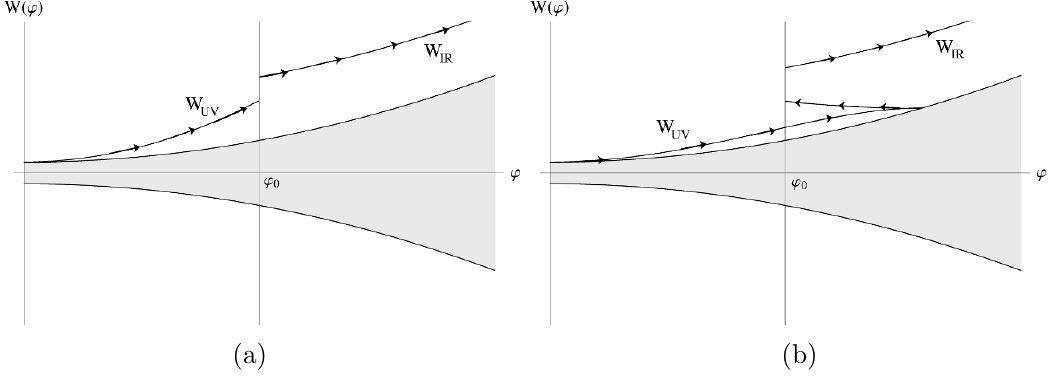
Figure 17 . The behavior of the full solution in case A 2, i.e. W B ( ’ 0 ) > 0 and W UV ( ’ 0 ) > B ( ’ 0 ). The left and right (cid:12)gures correspond to W 0 the analog situation in case A 1 ((cid:12)gure 16 (b)), the solution bounces at ’ > ’ 0 before reaching the interface from the